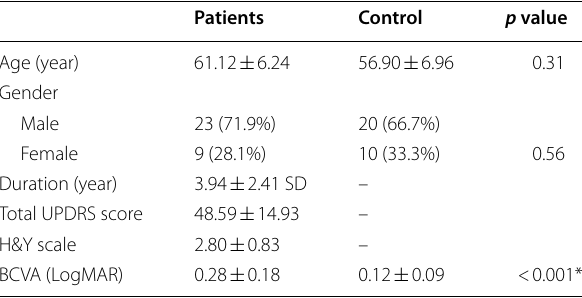
Table 1 Demographic and clinical data of the studied groups